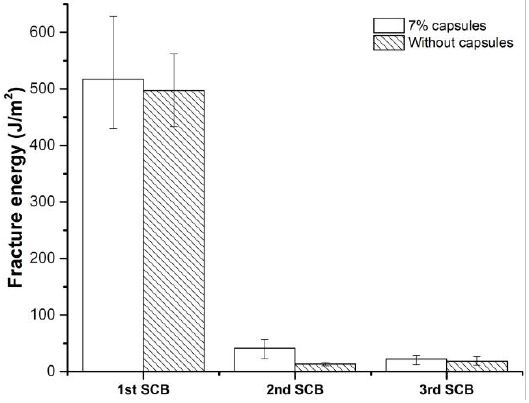
Figure 13. Fracture energy of SCB specimens.